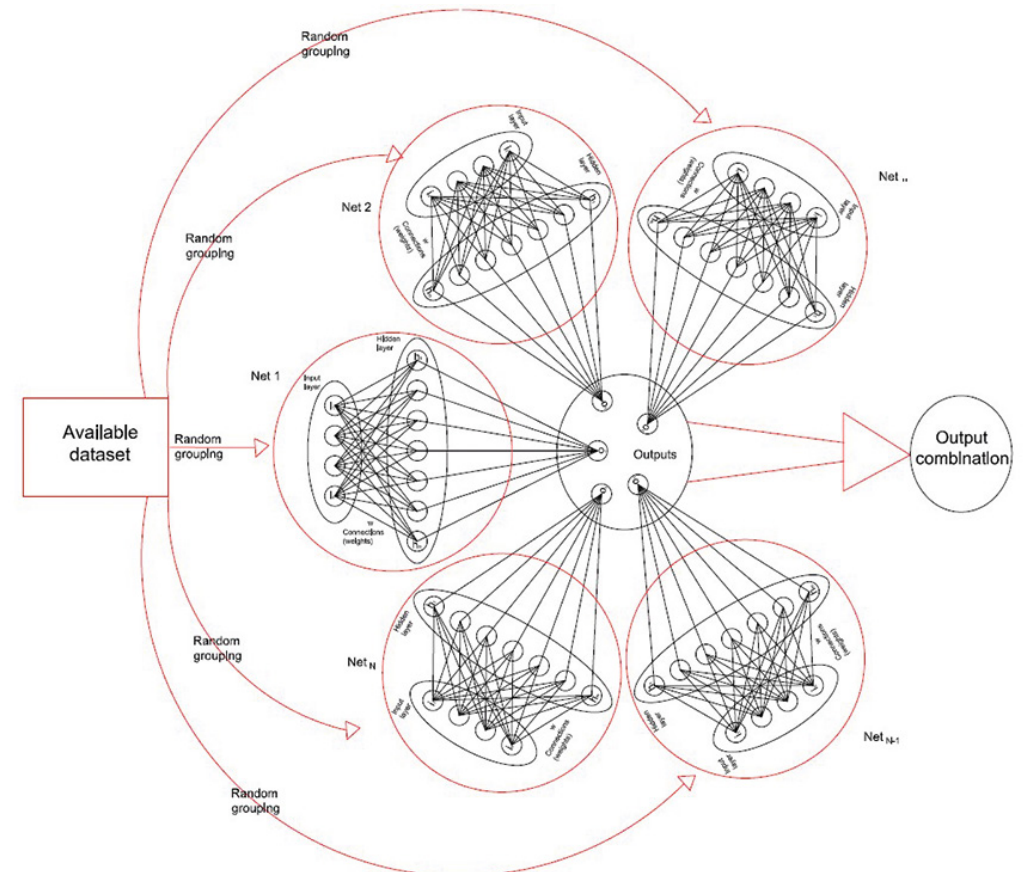
Figure 1. Representation of an Artificial Neural Network